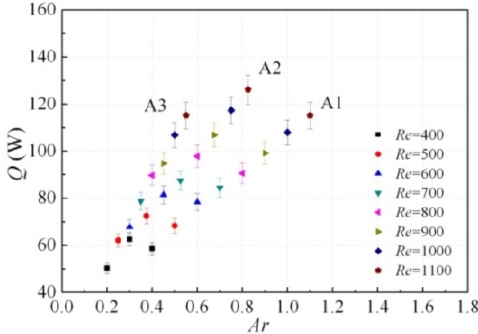
Figure 12. Heat transfer rate variation with A r , Va = 200.